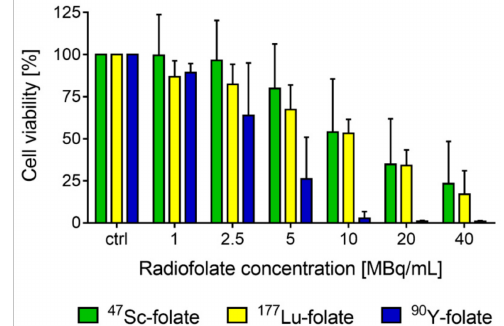
Figure 2. IGROV-1 cell viability after treatment with di ff erent quantities of 47 Sc-folate (green), 177 Lu-folate (yellow), and 90 Y-folate (blue). The average of four, five, or three independent experiments is shown for 47 Sc-folate, 177 Lu-folate, and 90 Y-folate,